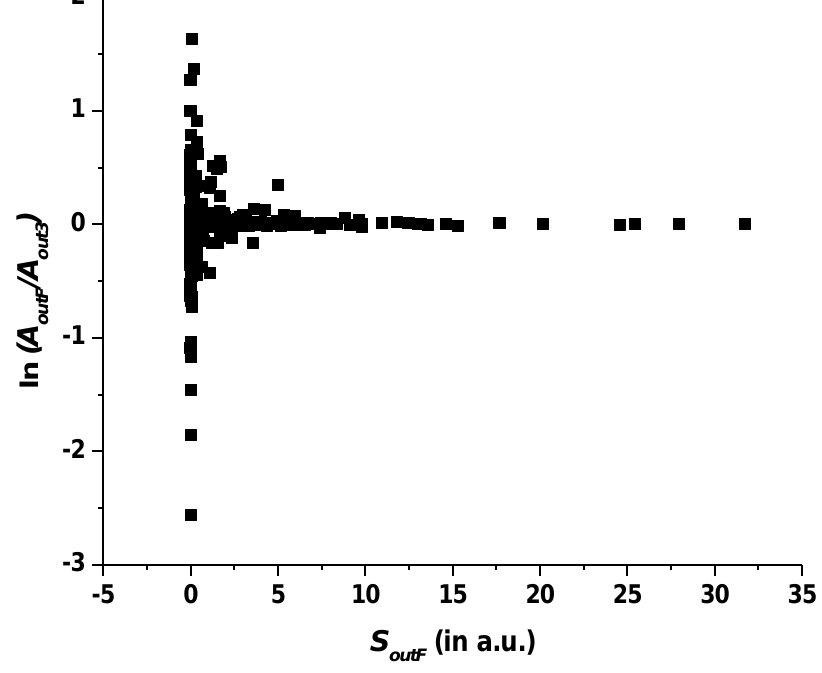
Figure 6. Natural logarithm of the ratio A outF / A out3 of the E2 transition rates calculated in the two largest calculations for W 13 + . The horizontal axis contains the line strengths S outF of the largest calculation in atomic units.